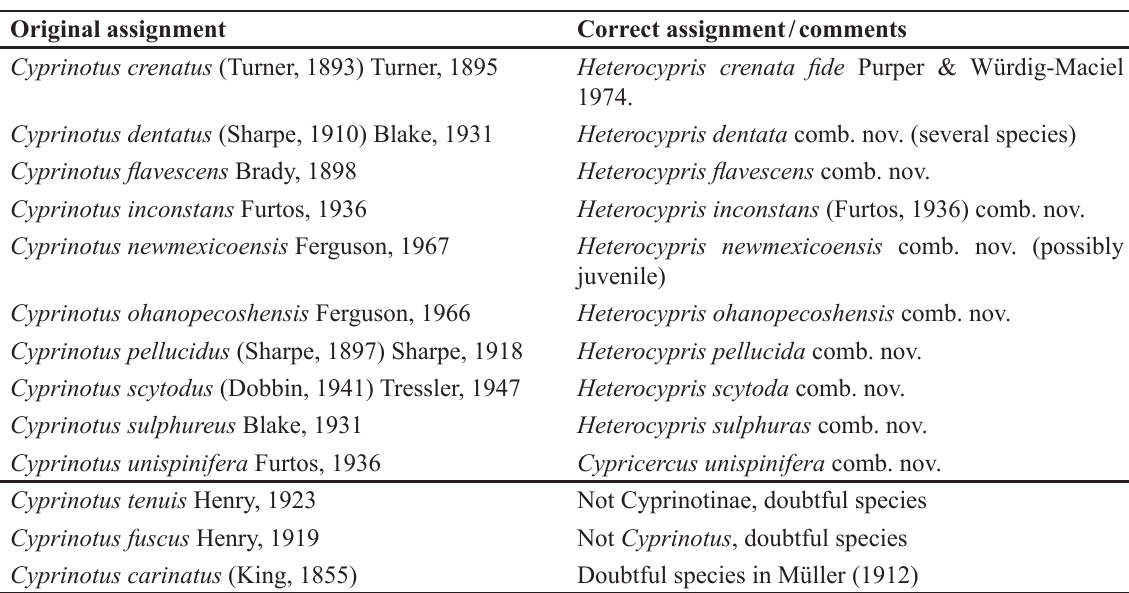
Table 3 . Re-assignment of species assigned to Cyprinotus by Meisch et al. (2019), based on the original